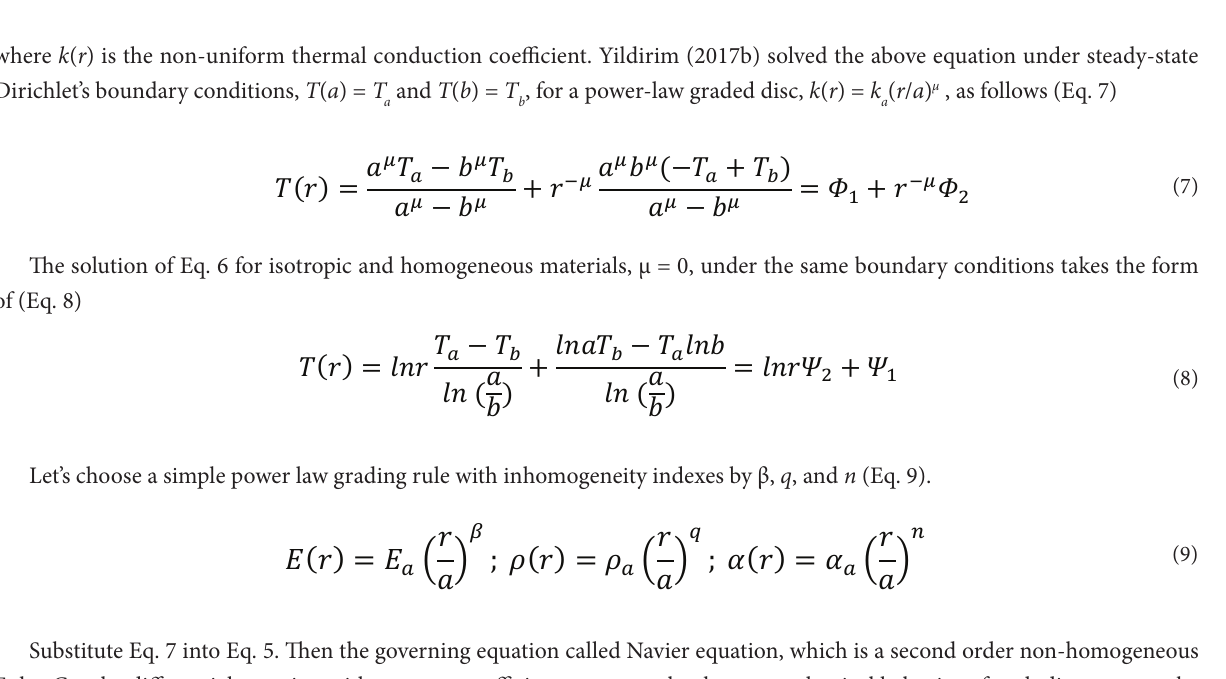
Now, it is time to determine the temperature distribution along the radial coordinate in a uniform disc, T ( r ) . After applying Fourier heat conduction equation with the first law of thermodynamics, the following differential equation governing the axisymmetric temperature distribution along the radial coordinate may be derived in cylindrical coordinates for discs made of arbitrarily graded FGMs (Eq. 6).